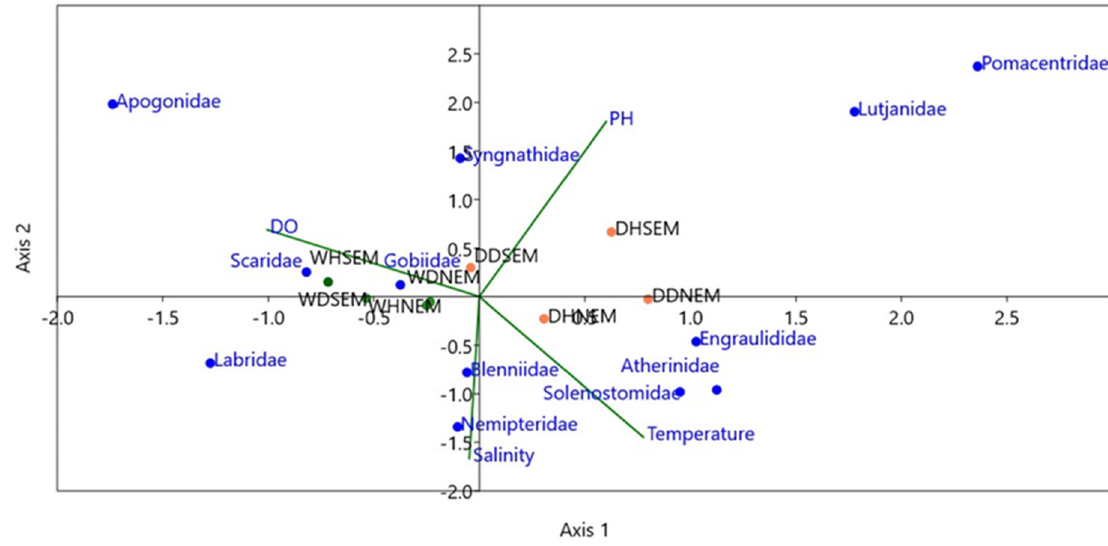
Figure 5. Canonical correspondence analysis (CCA) biplot depicting association of environmental variables (dissolved oxygen, salinity and temperature) among species at the study sites (Diani vs. Watamu), as well as status (Healthy vs. Degraded) with environmental variables presented as vectors (DD = Diani degraded, DH = Diani healthy, WD = Watamu degraded, WH = Watamu healthy).